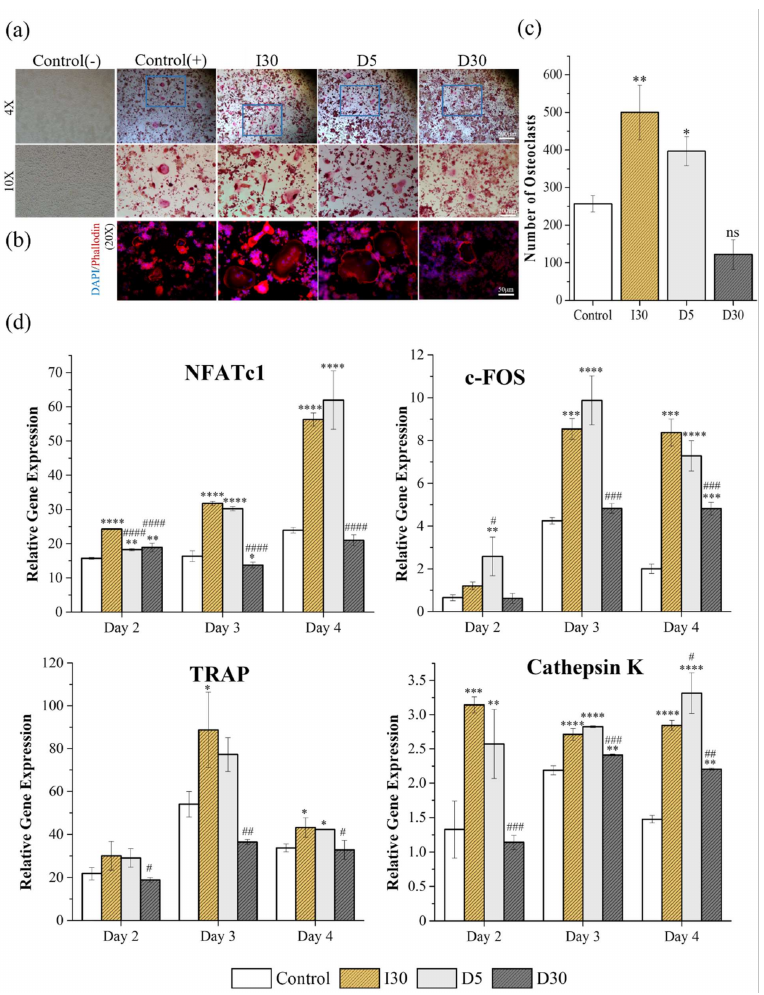
Figure 4. Osteoclast differentiation from the extract of NaI-incorporated paste (NaI@P) by ( a ) TRAP staining, and ( b ) Actin ring staining. ( c ) Number of osteoclast differentiation from TRAP staining. ( d ) The gene expression of c-FOS, NFATc1, cathepsin K, and TRAP measured by qPCR. The statistical significance of ( c ) was calculated using a one-way analysis of variance (ANOVA) and that of ( d ) was calculated using two-way ANOVA followed by a two-sided Tukey’s multiple comparison test. (*) compared to the positive control, (#) compared to the I30 group. */# represents p < 0.05, **/## p < 0.01, ***/### p < 0.001, ****/#### p < 0.0001, n =